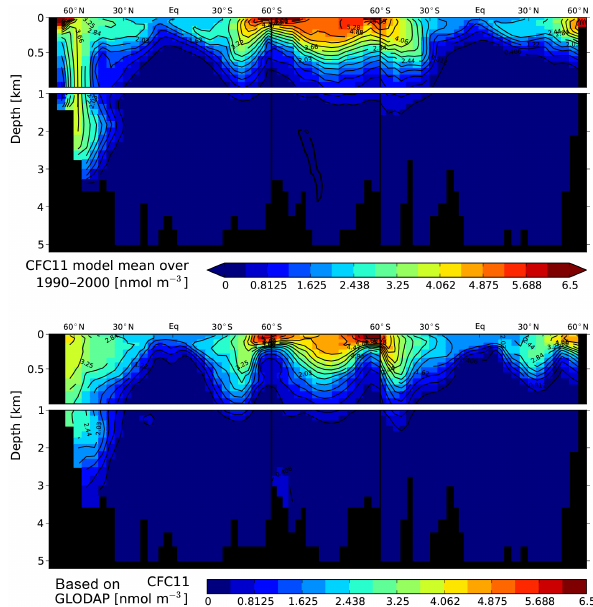
Figure A3. Top: distributions of CFC11 (nmolm − 3 ) as simu- Figure A2. Top: distributions of (natural) (cid:49) 14 C of DIC (‰) as sim- lated with a standard k dia of 0 . 2 × 10 − 4 m 2 s − 1 averaged over ulated with a standard k dia of 0 . 2 × 10 − 4 m 2 s − 1 at steady state. Bot- the model years 1990–2000 and (bottom) as observed (Key et al., tom: as estimated from (cid:49) 14 C measurements (Key et al., 2004). The 2004). The correlation coefficient, σ obs. and RMSEs are 0.9, 1.01, rel. correlation coefficient, σ obs. and RMSEs are 0.89,1.46, 23.77‰ in rel. 0.45nmolm − 3 in the Atlantic; 0.94, 1, 0.29nmolm − 3 in the Pa- the Atlantic; 0.95, 0.97, 16.28‰ in the Pacific; 0.9, 0.78, 21.1‰ cific; 0.83, 0.92, 0.54nmolm − 3 in the Indian Ocean. The sec- in the Indian Ocean. The section displayed is through the Atlantic tion displayed is through the Atlantic (25 ◦ W), the Southern Ocean (25 ◦ W), the Southern Ocean (58 ◦ S), and the Pacific (175 ◦ W). (58 ◦ S), and the Pacific (175 ◦